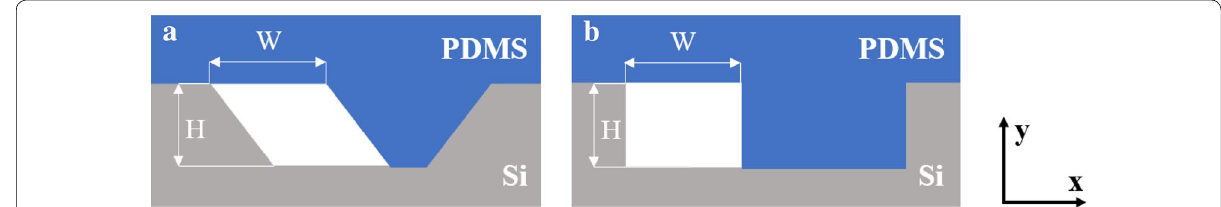
Fig. 1 Schematic view of microchannels with a parallelogram and b rectangular cross‑section. Channel height is constant, but aspect ratio ( AR W/H ) is modified by with the channel =